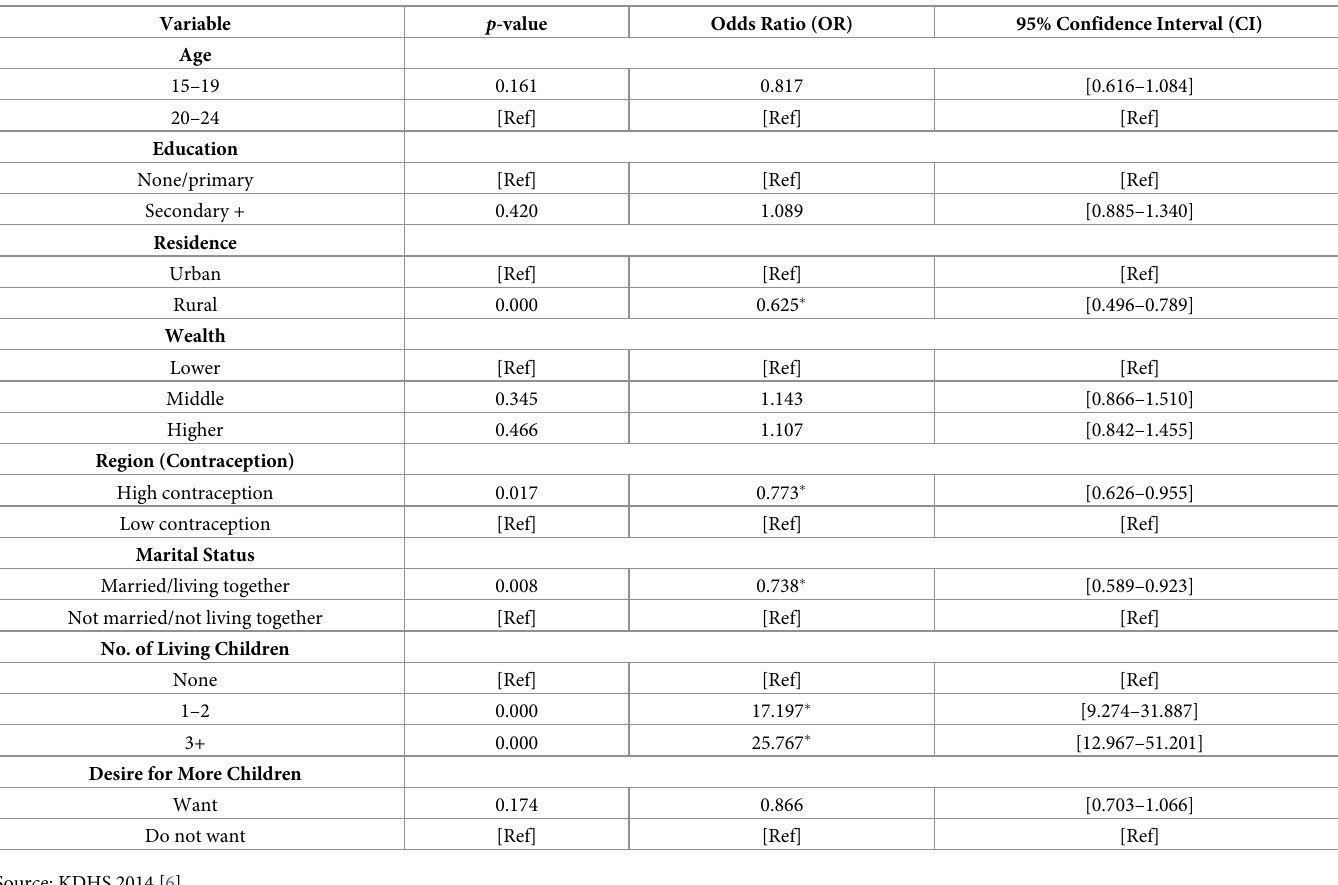
Table 4. Logistic regression estimates for use of LARC among women aged 15–24 in Kenya,